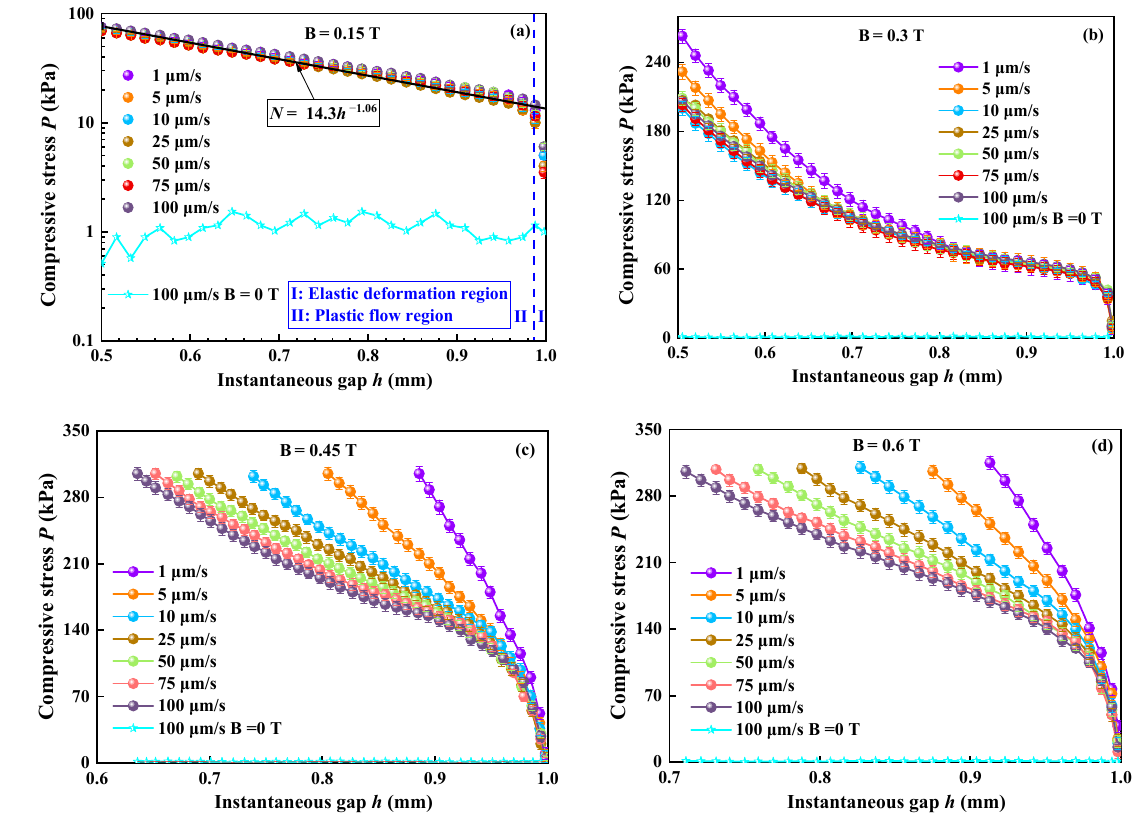
Figure 3. The curves of compressive stress under different compressive speeds. ( a ) B = 0.15 T; ( b ) B = 0.3 T; ( c ) B = 0.45 T; ( d ) B = 0.6 T.